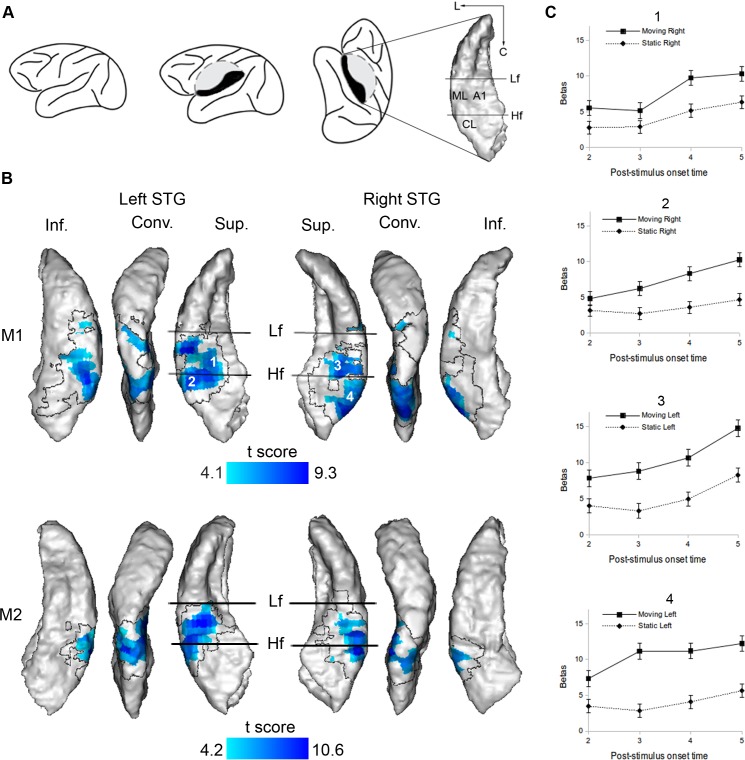
Motion minus Stationary contrast.(A) Location of the superior temporal gyrus (STG) surface and of the auditory areas in context. The dashed line corresponds to a cut through the operculum to expose the superior bank of the STG (in black). The relative positions of the primary core area, A1, and the secondary belts areas, middle lateral (ML) and caudolateral (CL), are indicated on the STG surface. The two straight lines represent the low-frequency (Lf) and high-frequency (Hf) reversals of tonotopy gradients. L; lateral; C: caudal. See also Materials and Methods and S1 Fig. (B) Motion minus Stationary contrasts (Experiment 1). Blood-oxygen-level-dependent (BOLD) responses were measured 5 s after the stimulus onset. Significant statistical parametric t maps are shown on a surface rendering of the STG of each individual (number of scans [n] = 2,466 [monkey 1, M1] and 3,429 [monkey 2, M2]; degrees of freedom [df] = 2,210 [M1] and 3,071 [M2]; p-values range after correction with the family-wise error (FWE) method [PFWE] from 0.05 to below 1x 10−10 [M1 and M2]). Since activation in the hemisphere ipsilateral to the stimuli was weak or absent, only contralateral activation is shown: Motion Left minus Stationary Left is projected on the right STG, while Motion Right minus Stationary Right is projected on the left STG. Three different views of each STG are represented: a top, a lateral, and a bottom view allowing the visualization of the superior bank (Sup.), the convexity (Conv.), and the inferior bank (Inf.) of the STG, respectively. The transparent region within the black boundary corresponds to motion-responsive regions (defined by the contrasts Motion Left minus Silence and Motion Right minus Silence, PFWE < 0.05) where the BOLD responses induced by motion and stationary stimuli were not significantly different. The numbers 1, 2, 3 and 4 indicate the locations where the plots illustrated in panel C are extracted from. (C) Hemodynamic response functions for motion and stationary stimuli in M1 (Experiment 2). The BOLD response (expressed by the response estimate coefficient, betas) was measured 2, 3, 4, and 5 s after the stimulus onset. The plots illustrate data from four representative individual voxels whose locations are indicated in panel B. ANOVA tests: n = 5,794, df = 4,905, F-values below 2.1, and all PFWE = 1. Error bars correspond to standard errors. Data are available from the Open Science Framework (https://osf.io/ut5pa/).